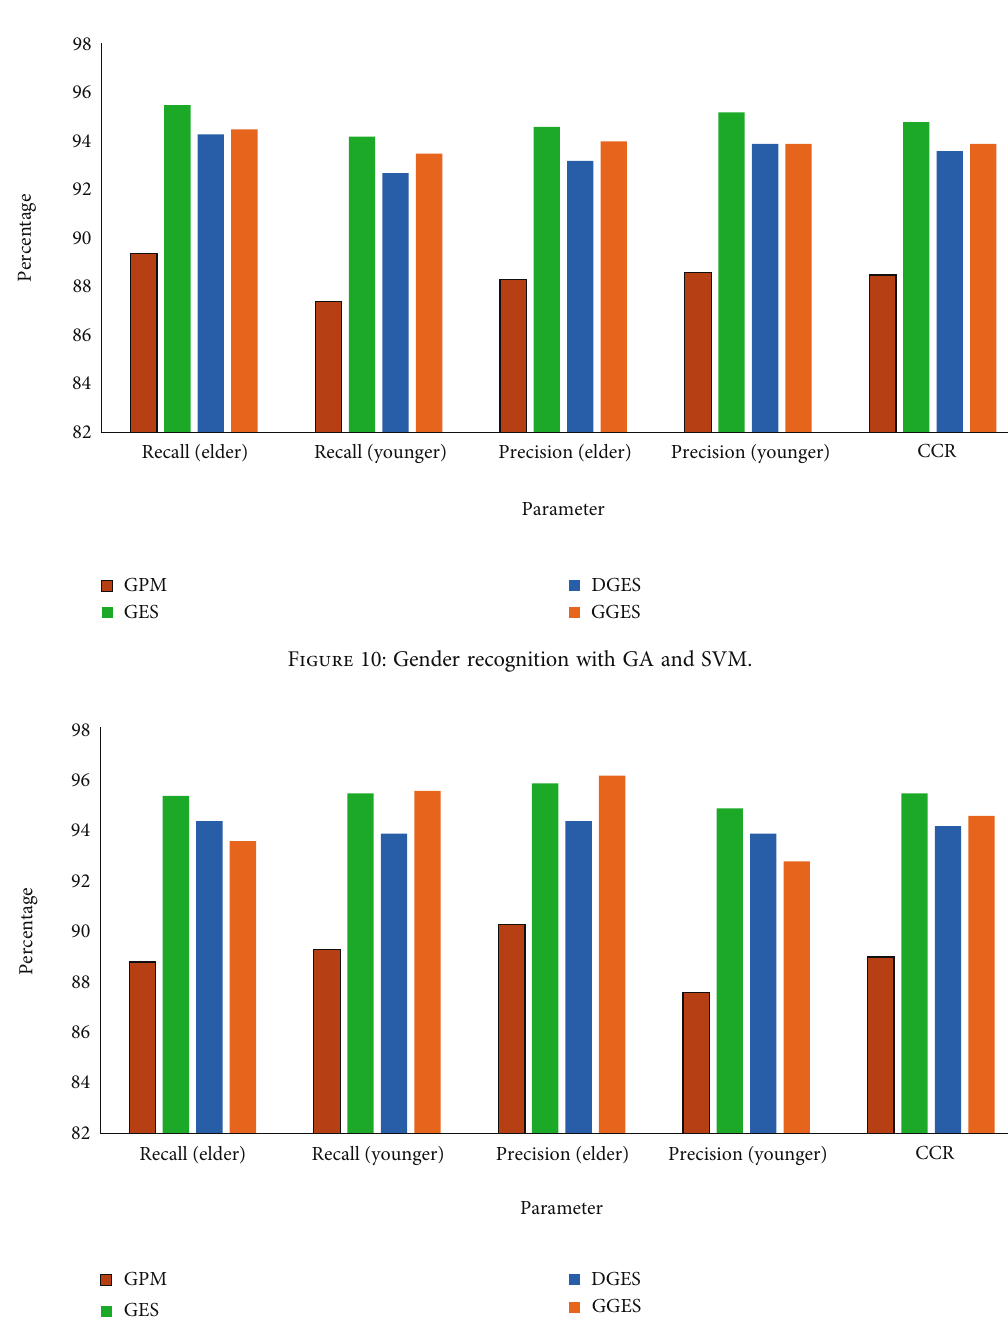
Figure 11: Gender recognition with PSO and